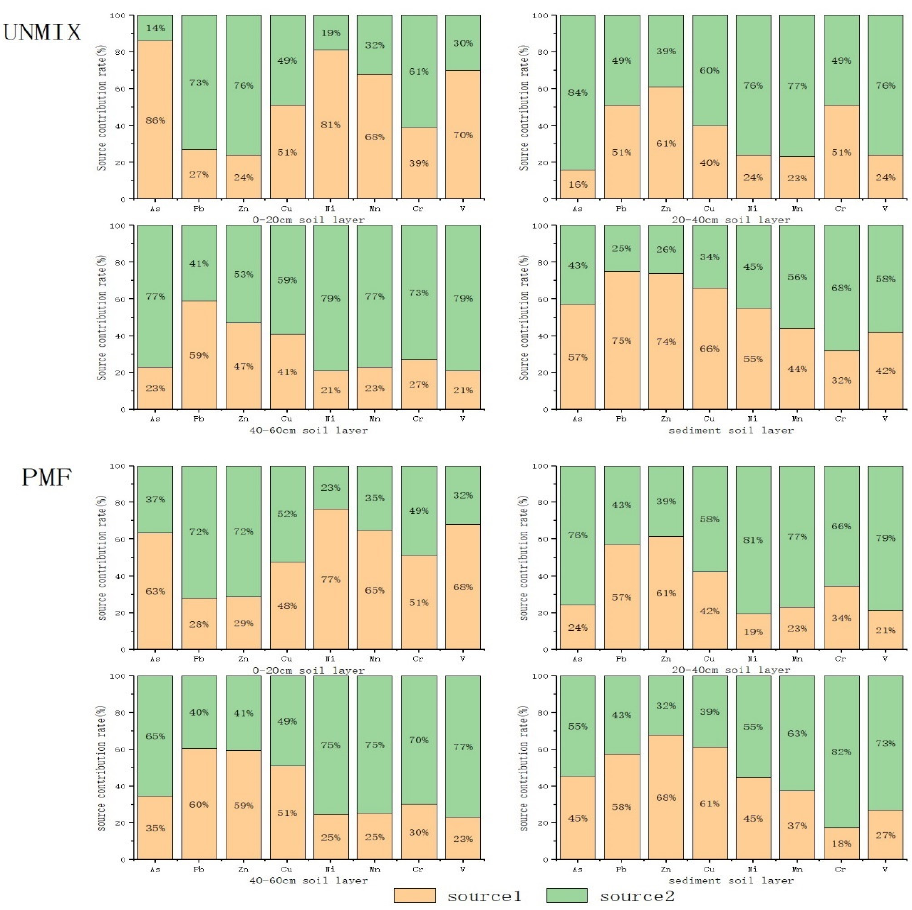
Figure 3. Contribution rates of different heavy metal sources in the study area (UNMIX and PMF). 5.4. Surface Distribution of Heavy Metal Concentration via the Kriging Interpolation